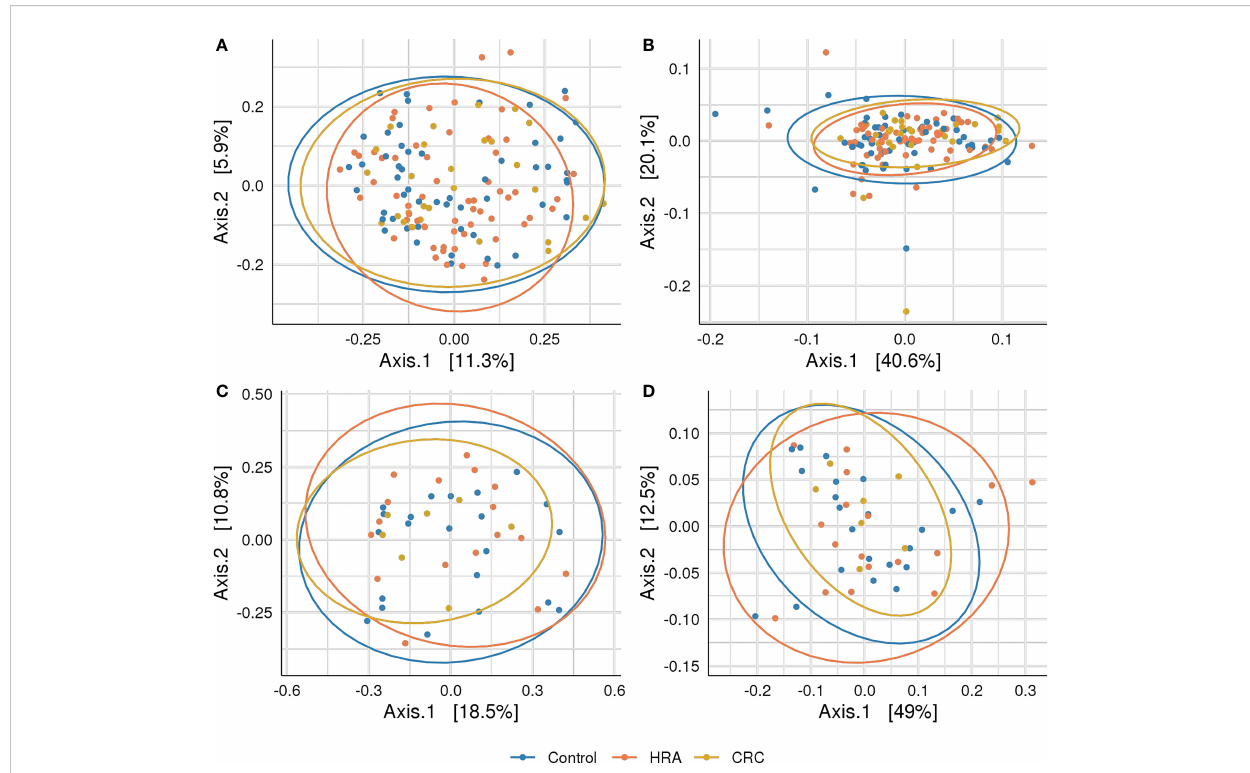
FIGURE 4 Beta diversity: PCoA plots with Bray – Curtis dissimilarity indices between CRC, HRA, and controls for (A) amplicon sequence variants from 16S sequencing data, (B) MetaCyc pathways derived from 16S sequencing data, (C) species abundance based on metagenome shotgun sequencing, and (D) MetaCyc pathways based on metagenome shotgun sequencing. Ellipses describe 95% of group variation for the principal coordinate axes. No signi fi cant ( p > 0.05) associations were identi fi